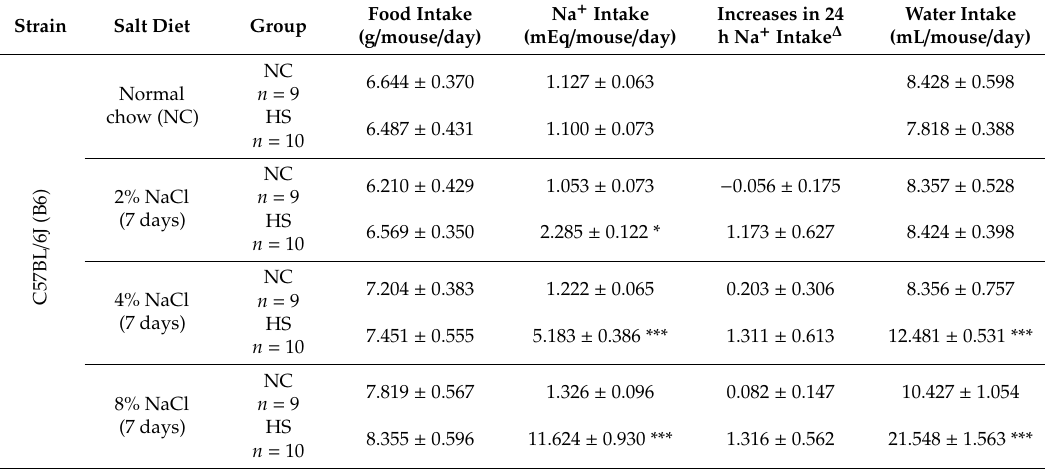
Figure 3. TH mice develop salt-sensitive hypertension due to blood volume expansion. Increased Na + intake ( A , n = 8–10) and water intake ( B , n = 8–10) were observed in both B6 and TH mice. ( C ) Renal function curve was plotted with systolic blood pressure (BP) on the abscissa and the Na + intake on the ordinate. Compared to the wild-type B6 mice, high salt significantly shifted the renal function curve to the right in obese TH mice ( n = 10–12). *** p < 0.001 versus TH NC at di ff erent amounts of Na + intake respectively. ( D ) Body weight gain ( n = 7–8). NC, normal chow group, 0.39% NaCl; HS, high salt group, 7 days of 2% NaCl, 7 days of 4% NaCl, and then 7 days of 8% NaCl. ** p < 0.01 versus TH NC at di ff erent amounts of Na + intake respectively. ( E ) Hematocrit ( n = 9–13). * p < 0.05. ( F ) Plasma albumin ( n = 8). * p < 0.05. Table 2. Food intake, Na + intake, and water intake in C57BL / 6J and TALLYHO / JngJ mice on normal and high salt